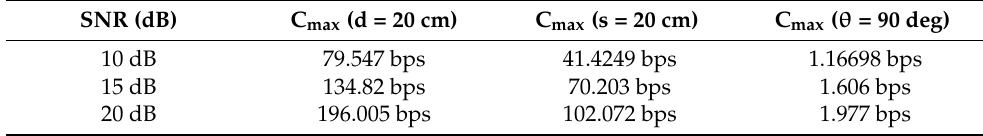
Table 3. The channel capacity calculated under different misalignment